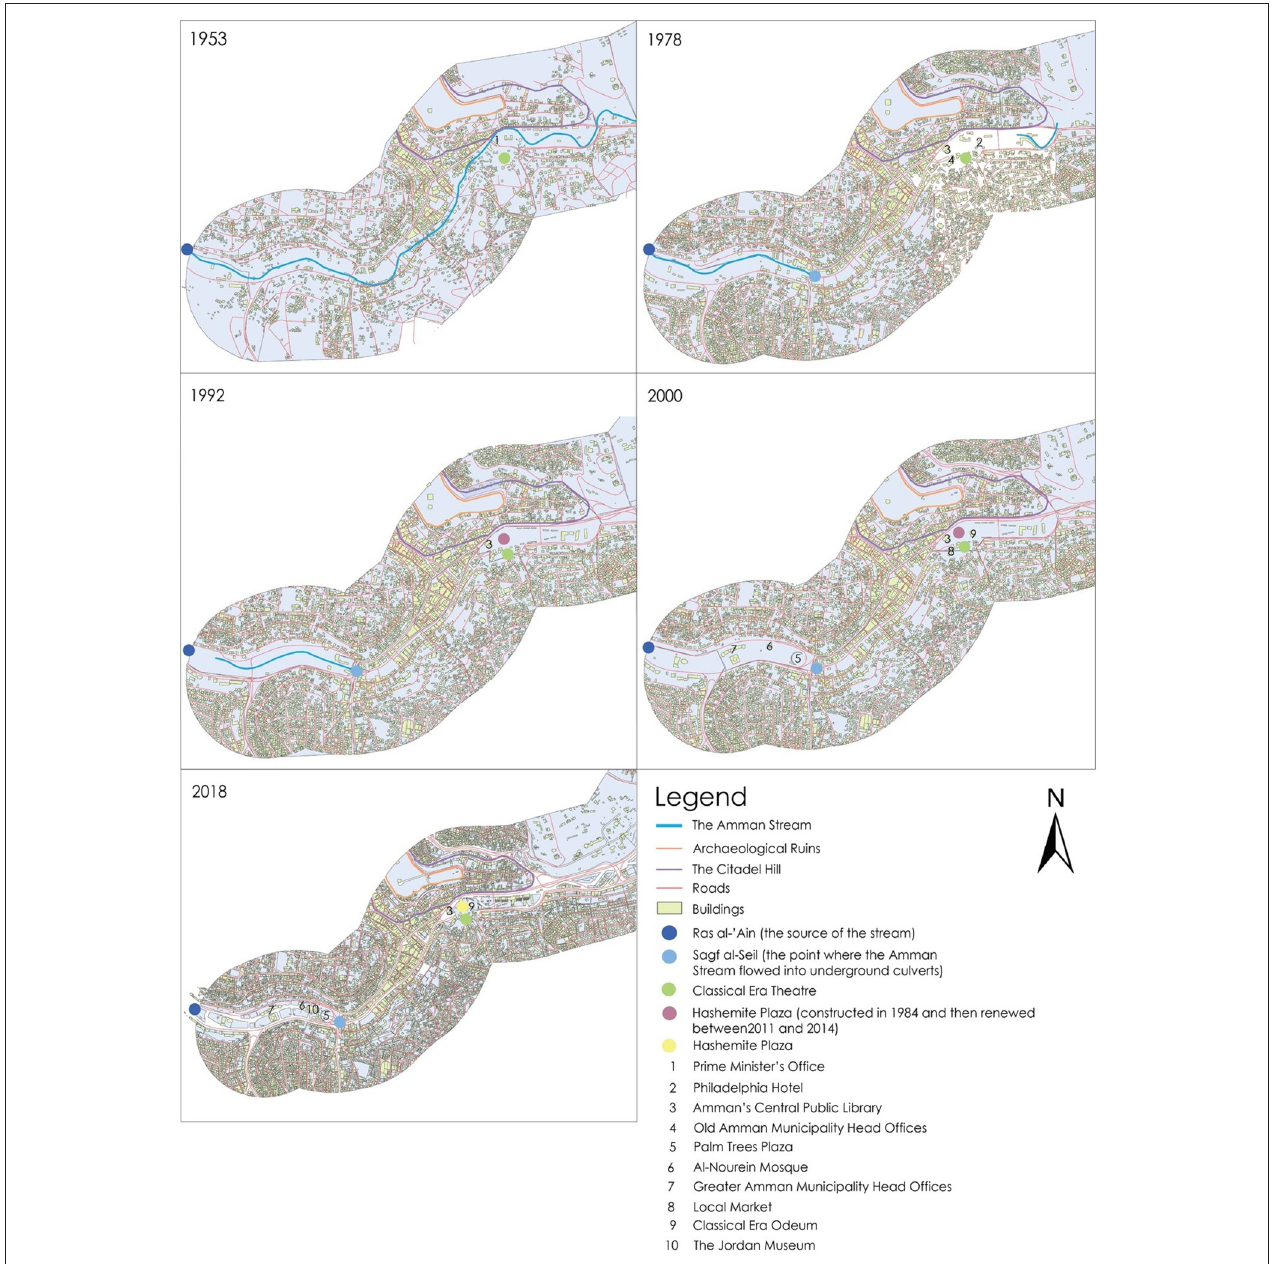
FIGURE 4 | Amman’s contemporary urban palimpsest showing changes to the town plan over time with the gradual loss of the Amman Stream (map produced by Sophie Wang under the supervision of Dr. Luna